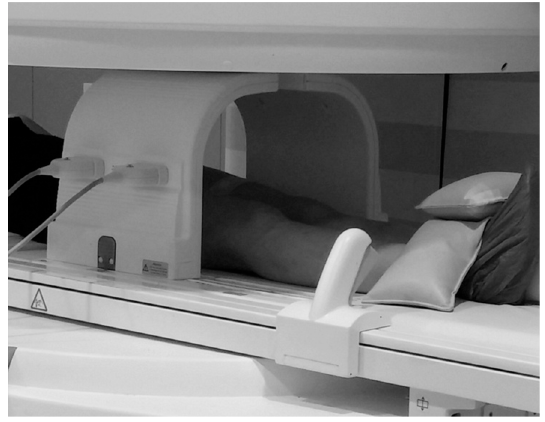
Figure 2. Magnetic resonance imaging (MRI) scanning procedure, with a participant lying supine, anterior mid-thigh under MRI body coil, and pillows at the ankle to maintain the hip in neutral.